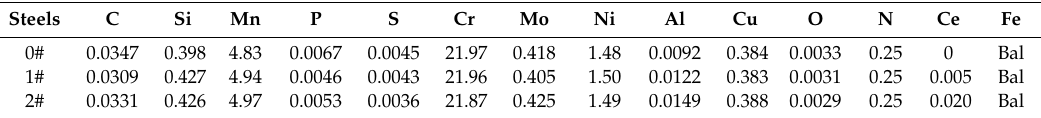
Table 1. Chemical compositions of LDX2101 experimental steels